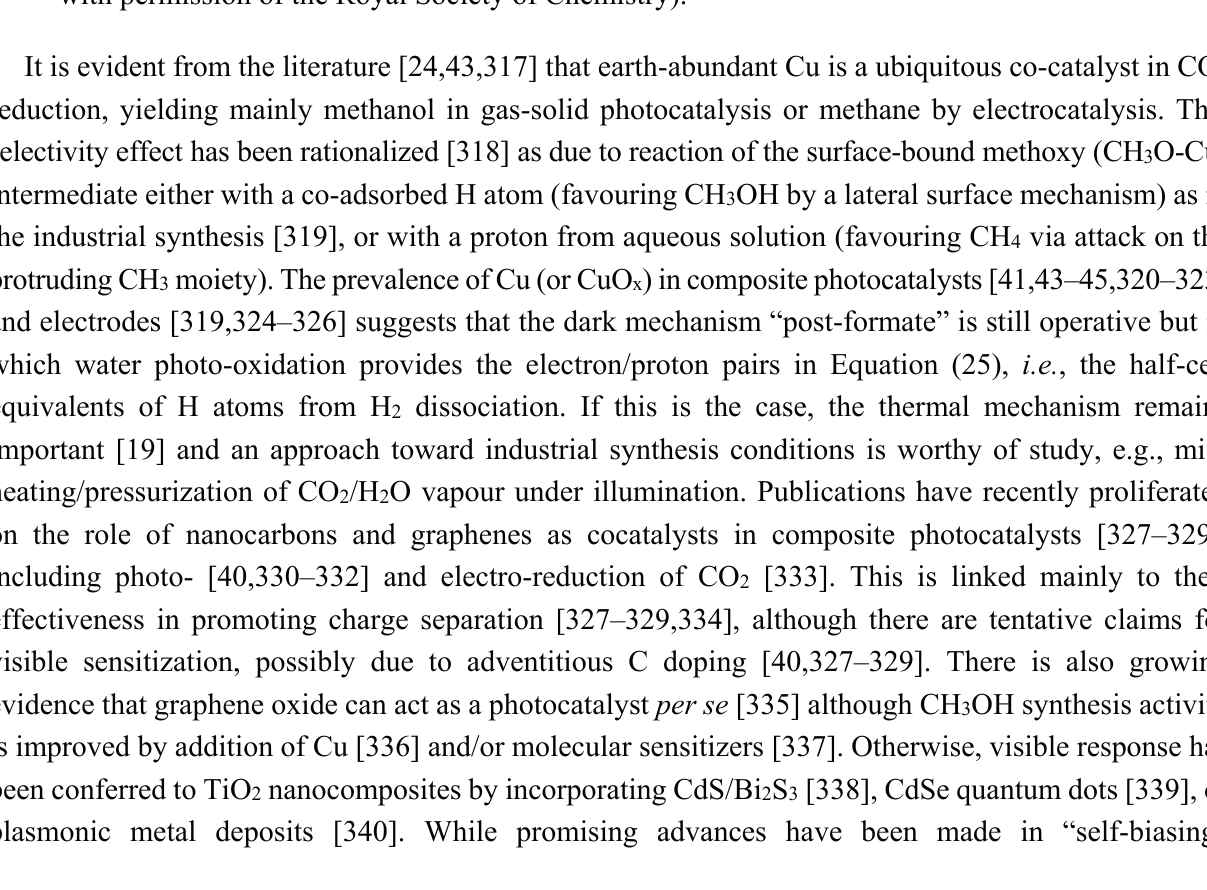
Figure 27. Pathways of 2e − /2H + photoreduction of CO 2 to formic acid. DFT energy barriers (<1 eV) favour the green route (via B1) and the red route (via A1) (reproduced from [316] with permission of the Royal Society of